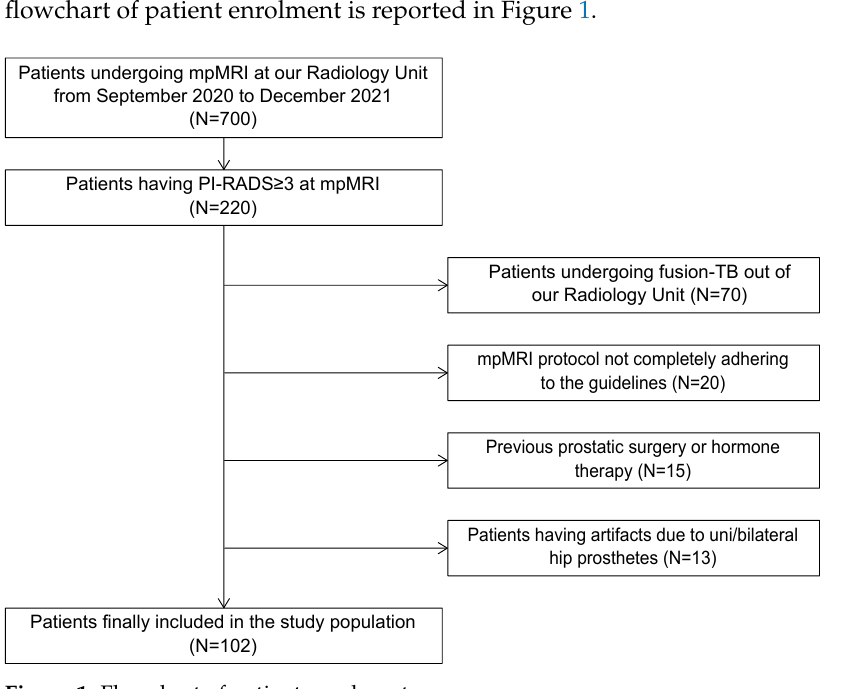
Figure 1. Flowchart of patient